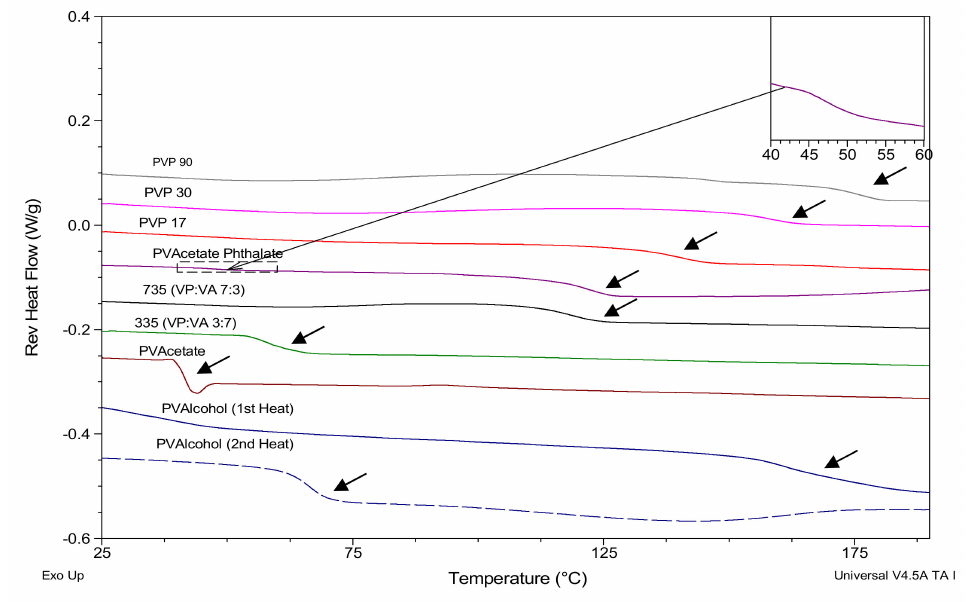
Figure 2. mDSC scans showing glass transitions of polymers. Inlay shows first glass transition of